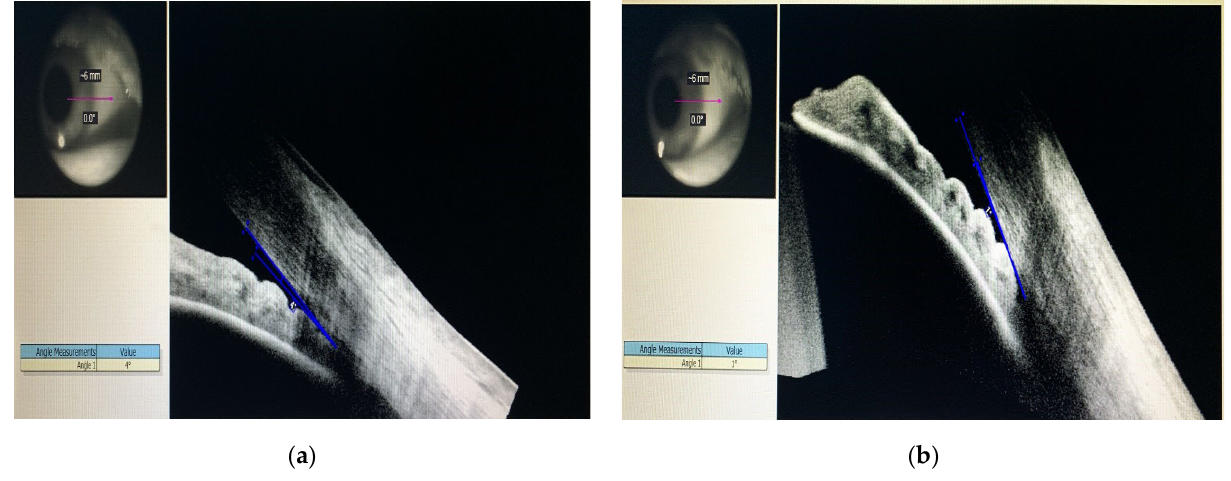
Figure 2. Gonioscopy in both eyes, supported by the anterior segment OCT: ( a ) Right Eye; ( b ) Left Eye. Based on the clinical and paraclinical examinations, the final diagnosis was upper hemi retinal vein occlusion (in the right eye), bilateral acute closed angle closure glaucoma, rheumatoid polyarthritis, systemic arterial